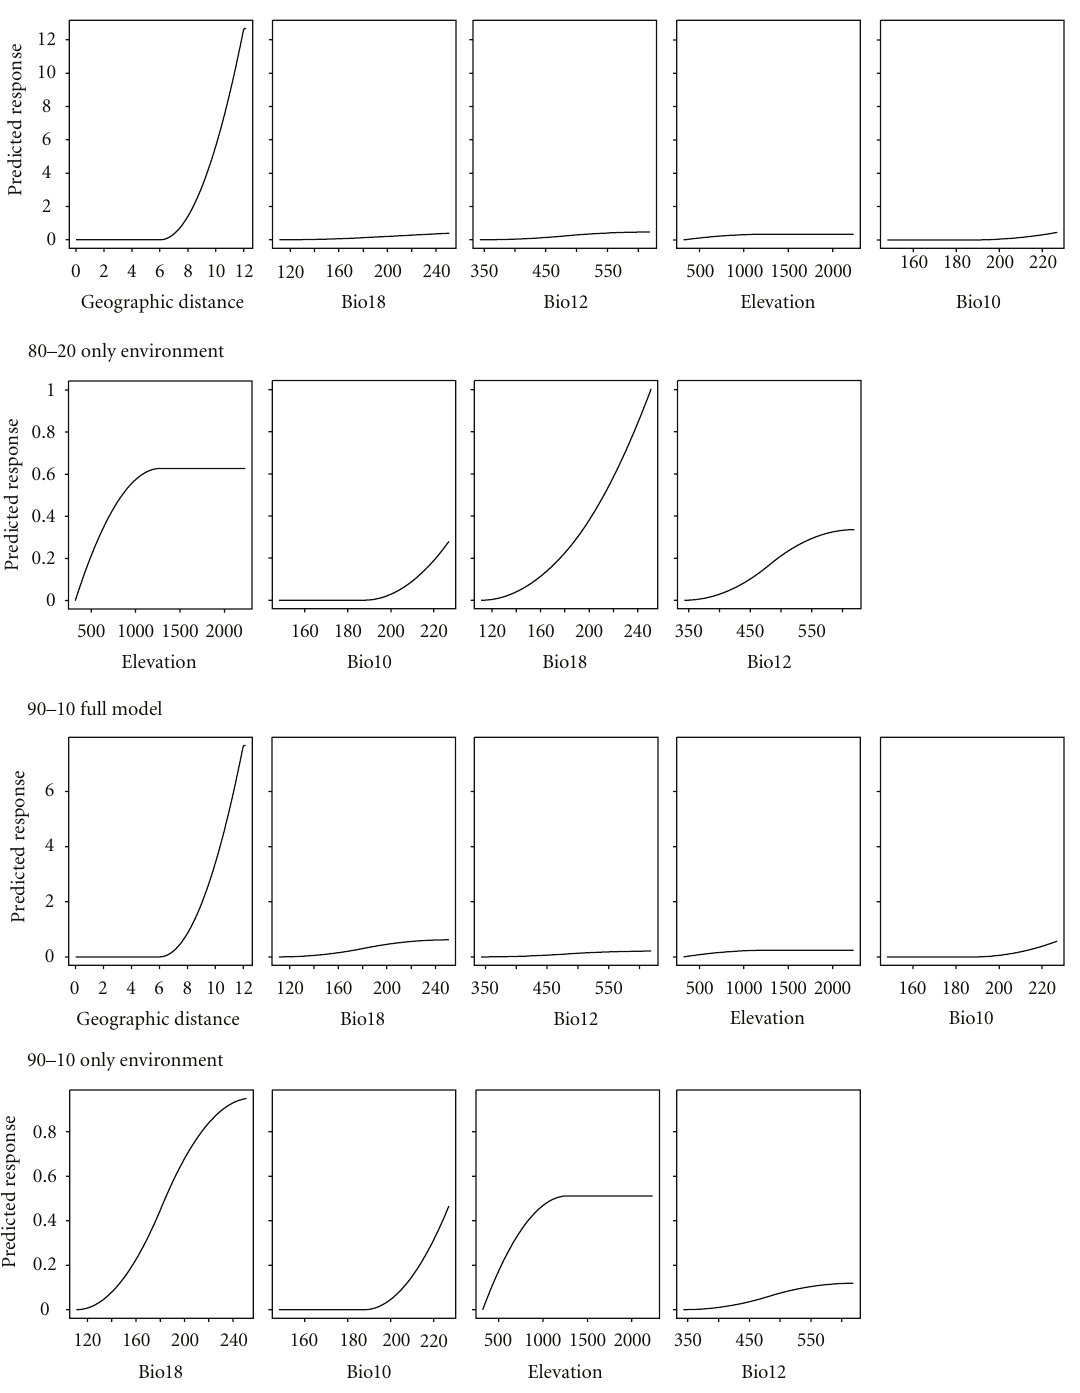
Figure 3: Response curves for generalized dissimilarity models of the proportion of pure P. amoena individuals, plus one half of the hybrid individuals, in a population. Results are shown for “80–20” and “90–10” criteria, and for full models (with both geographic distance and environmental variables) and models using only environmental variables. Response curves in GDM are nonlinear, but constrained to be monotonic. The slope of each function is indicative of the rate of change in the proportion of hybrids along the environmental gradient concerned. The maximum height of a response curve indicates the relative importance of that variable in explaining the observed variation in the similarity between populations in the proportion of hybrids. The y -axes indicate fitted functions f ( x ), where x denotes the environmental variable concerned. Each of the functions is fitted as a linear combination of I-spline basis functions